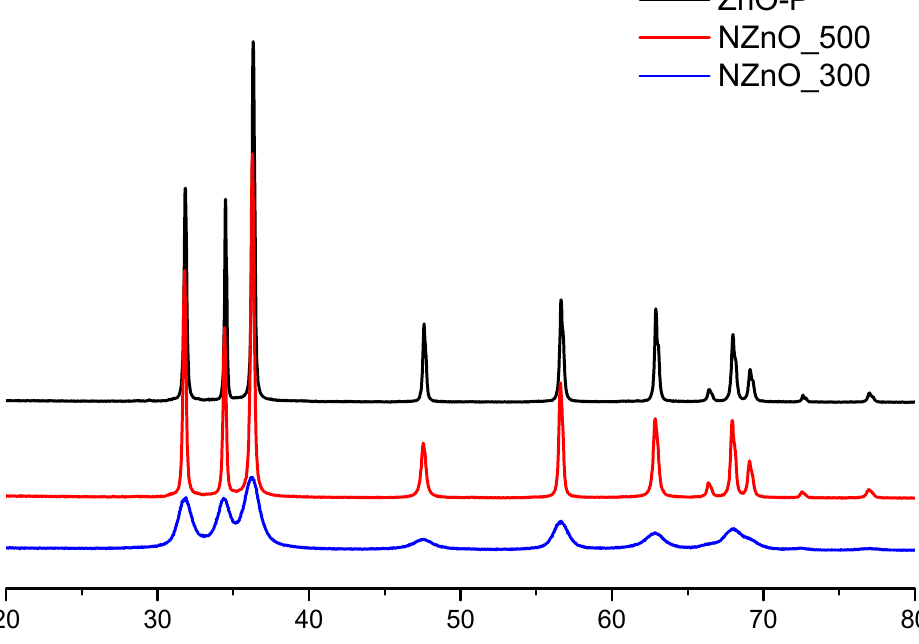
Figure 1. XRD patterns of ZnO (black), NZnO calcined at 500 °C (red), and NZnO calcined at 300 °C (blue) samples.